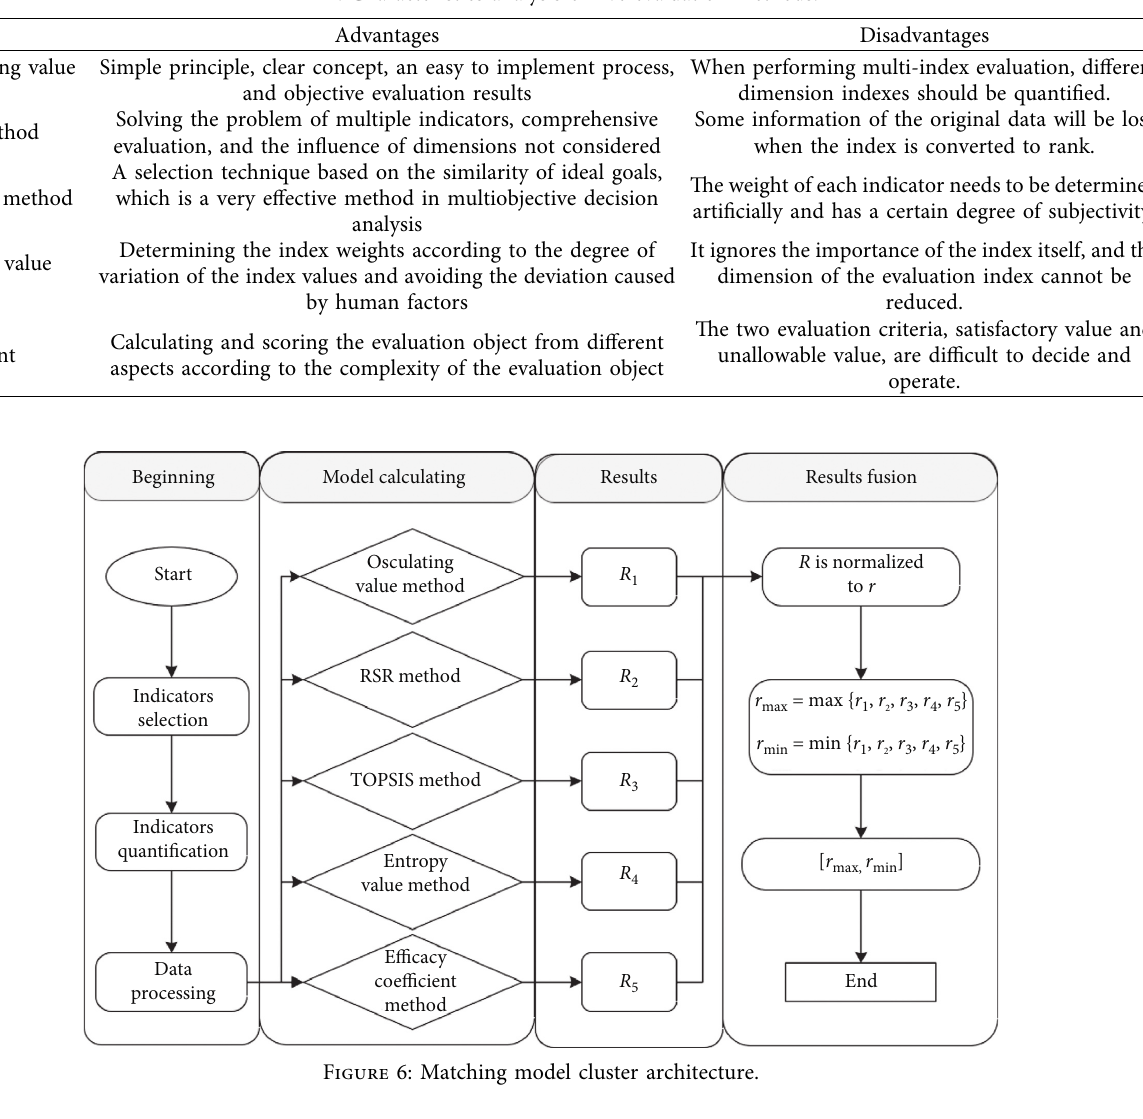
Table 2: Characteristics analysis of five evaluation methods.